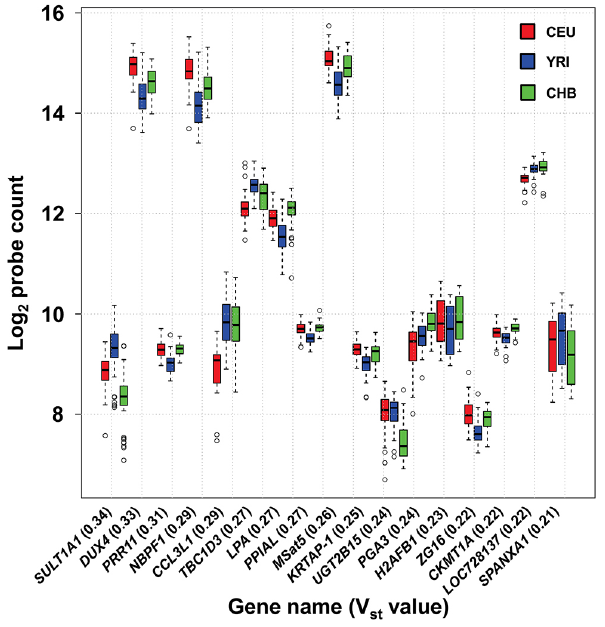
Figure 2. High frequency of population stratification for CNV of multicopy genes. 17 of 116 (14.7%) multicopy genes show high levels of differentiation in copy number (V st . 0.2) among European, African and Asian populations. Note that probe counts on the y-axis are shown on a log2 scale.